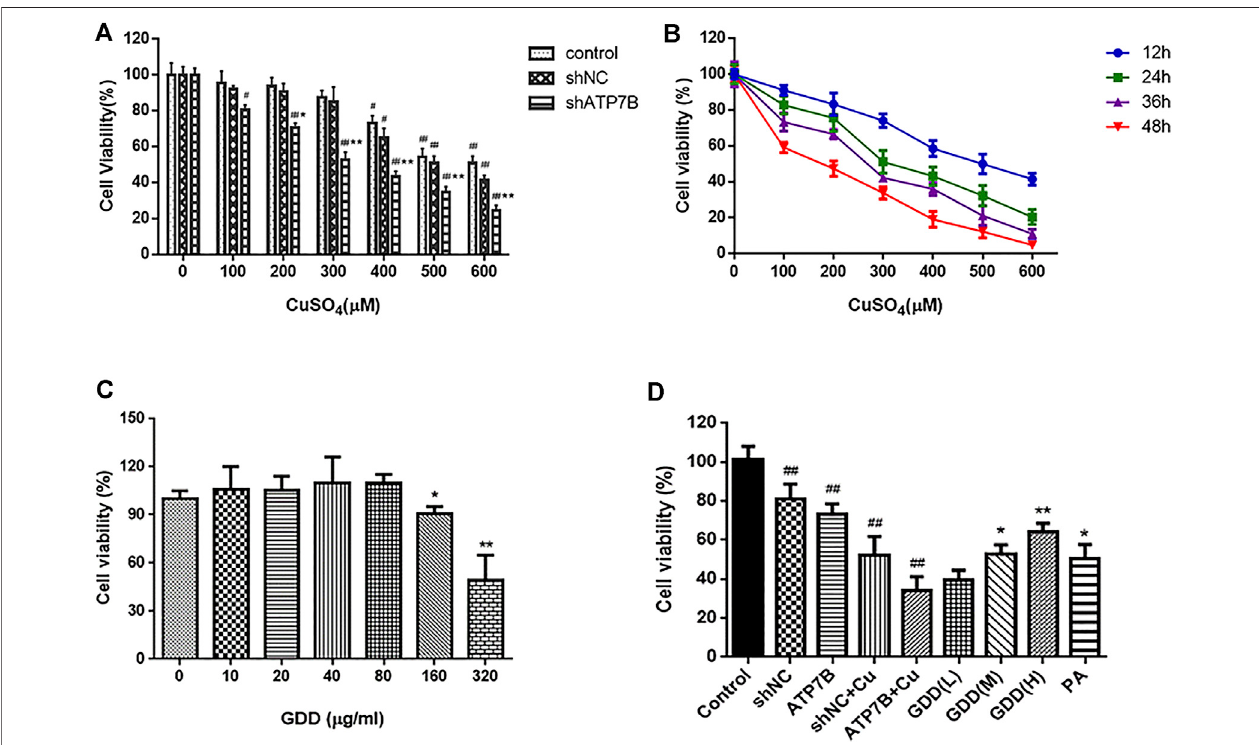
FIGURE 1 | (A) Cell viability in control, shNC, and shATP7B transfected after 24-h incubation with different concentrations CuSO 4 ( (cid:1) x ± s , n (cid:1) 6). # p < 0.05, ## p < 0.01 compared with corresponding blank group without CuSO 4 treatment; * p < 0.05, ** p < 0.01 compared between shNC and shATP7B groups at same copper concentration; (B) dose and time-effect curves of shATP7B transfected cell viability after incubation with CuSO 4 ( (cid:1) x ± s , n (cid:1) 6); (C) cell viability after 24 h treated by GDD ranging from 0 to 320 μ g/ml (0, 10, 20, 40, 80, 160, and 320 μ g/ml) ( (cid:1) x ± s , n (cid:1) 6). * p < 0.05, ** p < 0.01 compared with control group; (D) cell viability in copper- laden HLD hepatocytes before and after GDD treatment ( (cid:1) x ± s , n (cid:1) 6). * p < 0.05, ** p < 0.01 compared with shATP7B + Cu